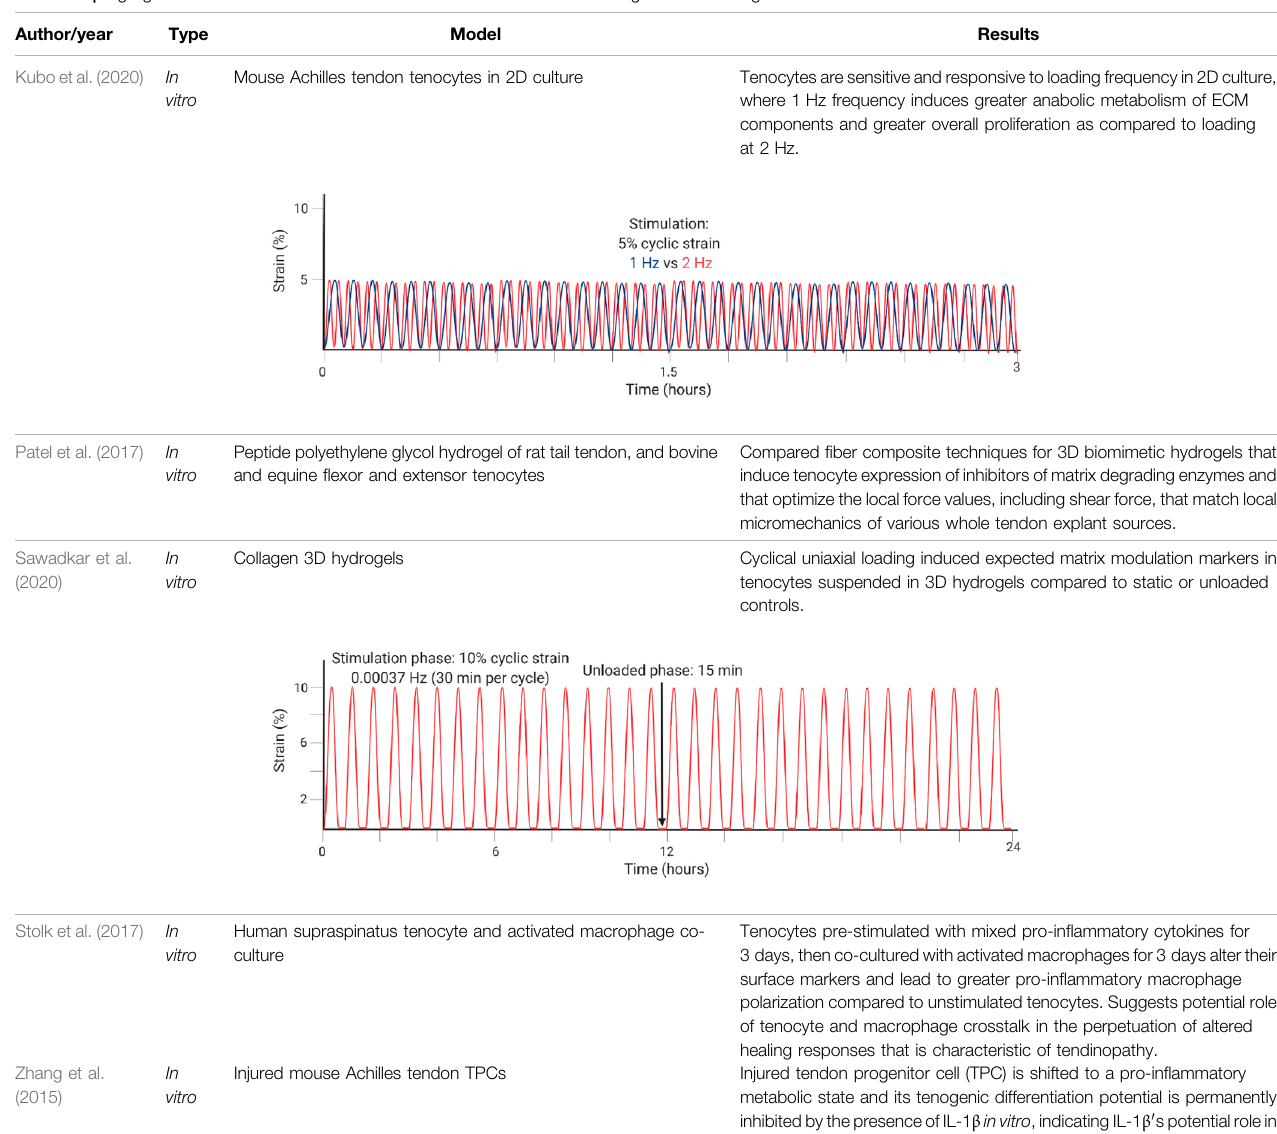
TABLE 2 | Highlighted summaries of recent in vitro studies with associated loading schemes. Images created with Biorender.com.